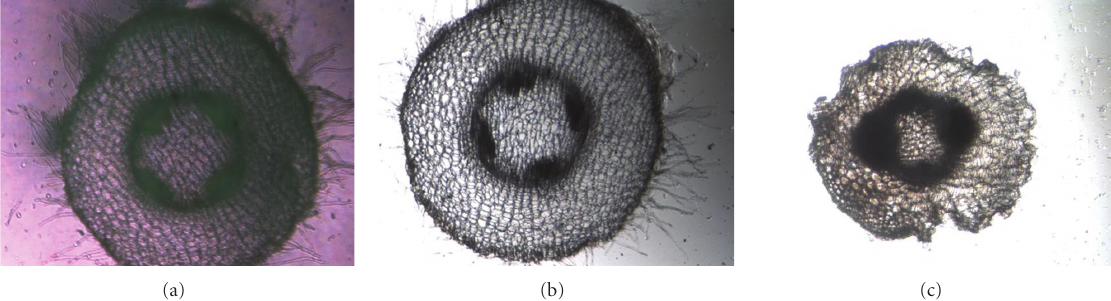
Figure 4: Transverse section of mung-seedling roots (a) control, (b) at 20 ppm, and (c) at 2000 ppm of nano-ZnO treatment.